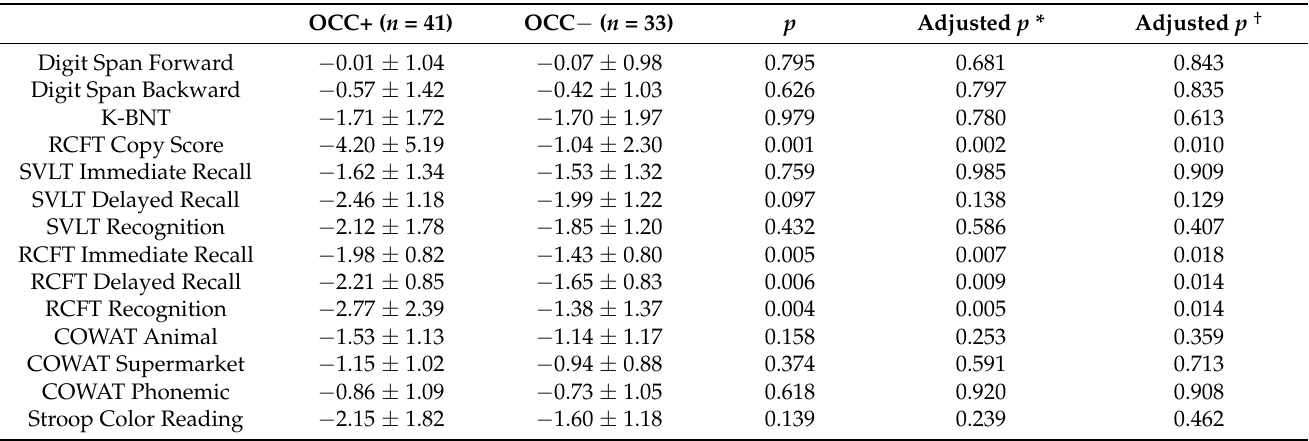
Table 3. Neuropsychological test results.